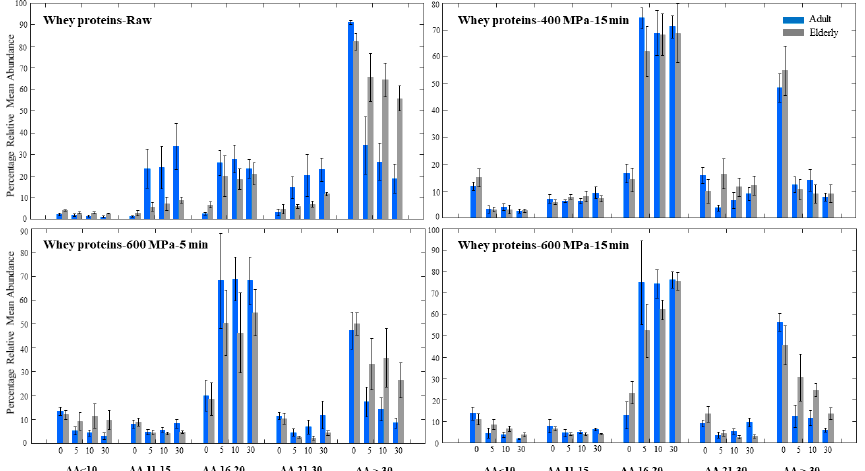
Figure 5. Relative mean abundance (%) of peptides originated from whey proteins including β -Lg, immunoglobulin, lactotransferrin, serum albumin, and α -La after 0, 5, 10, and 30 min gastric digestion of raw milk and various HPP treated milks using the in vitro adult and elderly models. The bars are the average of two independent replicates and the error bars represent the standard deviations.